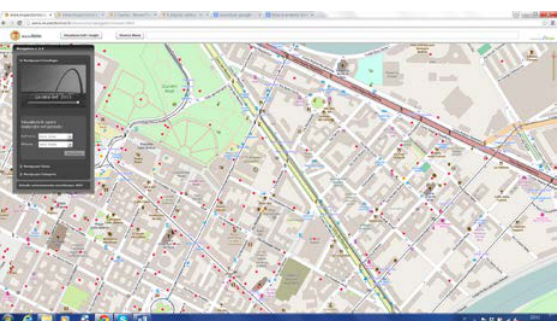
Figure 9. The WEBGIS of Museo